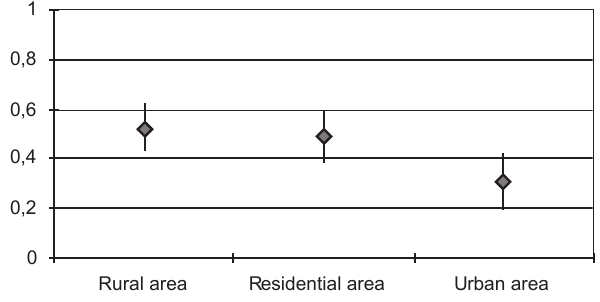
Fig. 4. – Worm burden distributions of Echinococcus multilocularis in infested red foxes (intensity of infection) from the canton of Geneva,